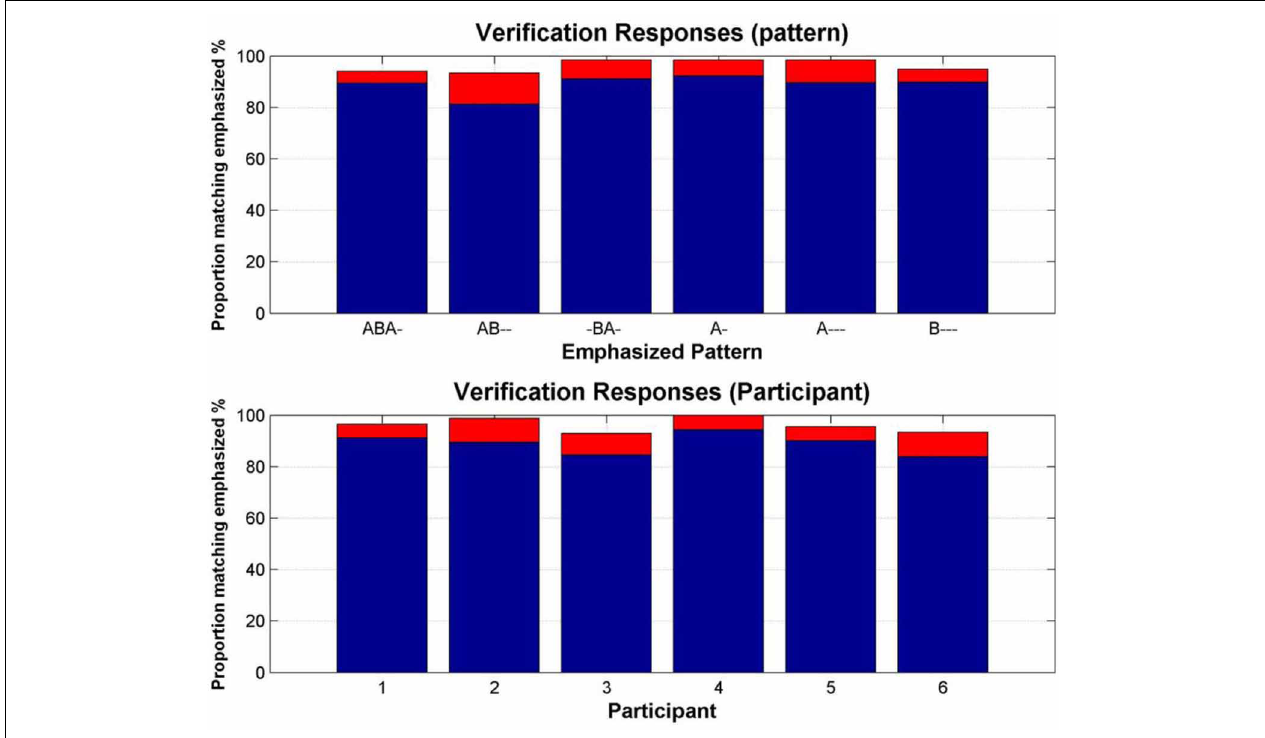
FIGURE 3 | Verification of pattern recognition. Top: Proportion of the verification sections in which each emphasized pattern was reported. Bottom: Proportion of the verification sections in which each participant